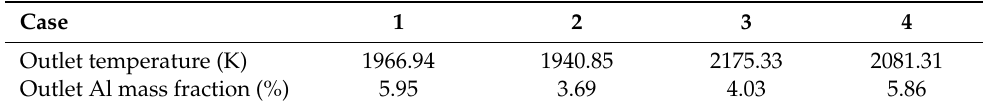
Table 4. Temperatures and Al mass fractions at the outlet lip after 550